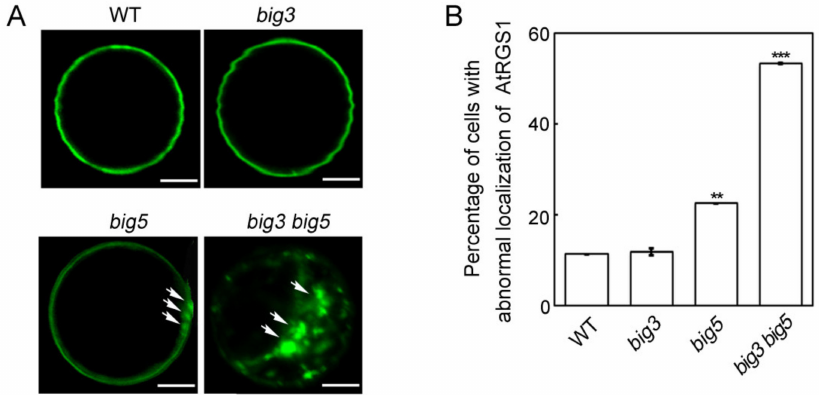
Figure 5. Subcellular localization of AtRGS1 in WT, big3 , big5 and big3 big5 protoplasts. ( A ) the fusion protein AtRGS1-YFP was transiently expressed in protoplasts from WT, big3 , big5 and big3 big5 cultured at 1/2 MS for 10 days. YFP fluorescence was observed 17 h later. Typical protoplasts of each genotype were shown. Bars = 10 µ m. White arrow heads indicate the dots in the cytoplasm in big5 and big3 big5 protoplasts. ( B ) percentage of cells with GFP signals retained in the cytoplasm. The values are presented as mean ± sd (n = 50). Asterisks indicate significant differences, compared to WT (**, p < 0.01; ***, p < 0.001. Student’s t test). Three independent experiments were performed.